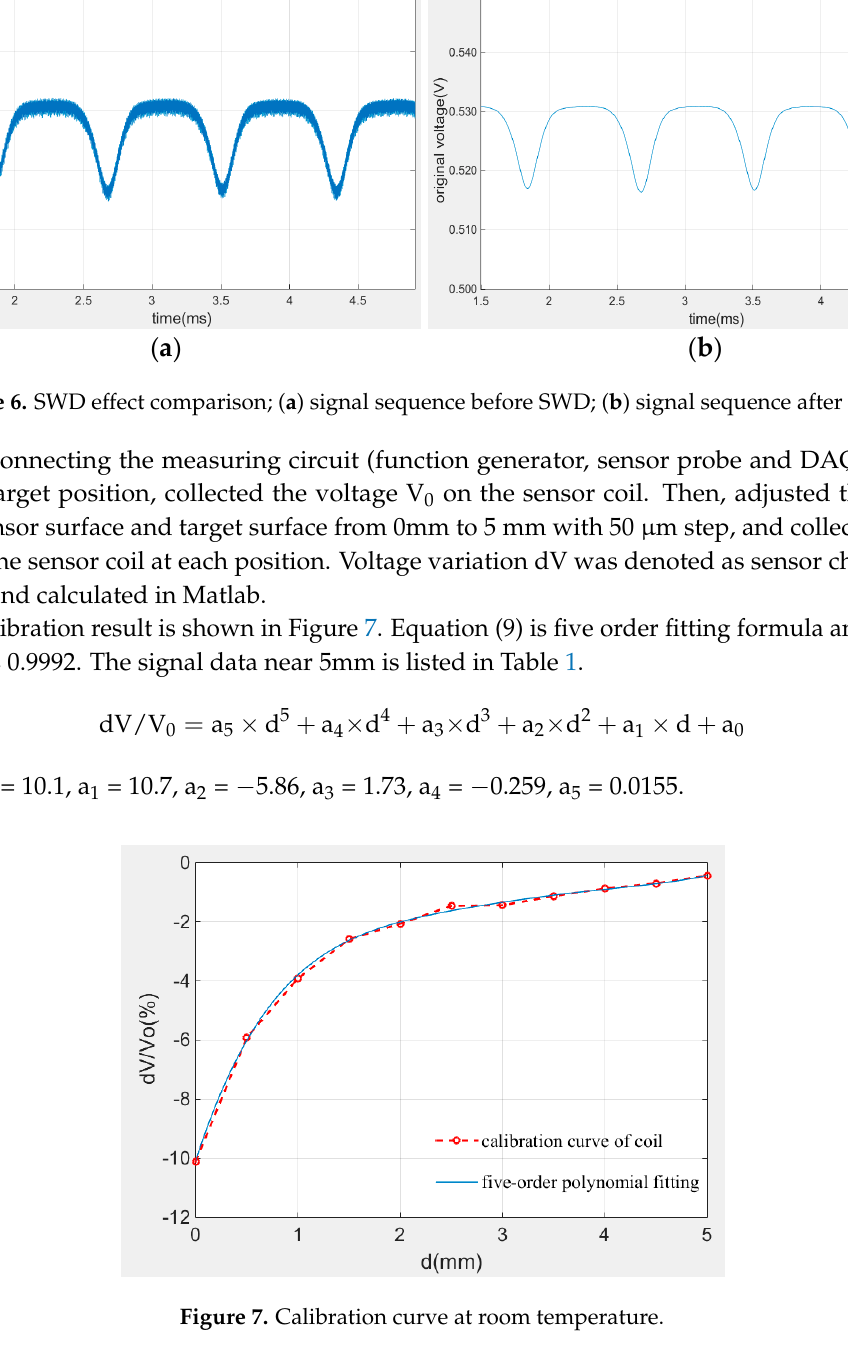
Figure 6. SWD effect comparison; ( a ) signal sequence before SWD; ( b ) signal sequence after SWD.